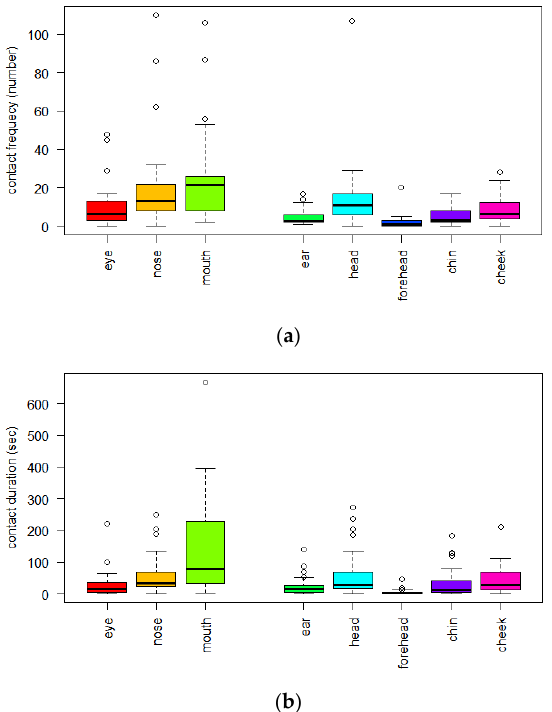
Figure 1. ( a ) Hand-to-face contact frequency ( n = 30, 2 h observation time, frequency/person/2 h); ( b ) Hand-to-face contact duration ( n = 30, 2 h observation time, sec/person/2 h).